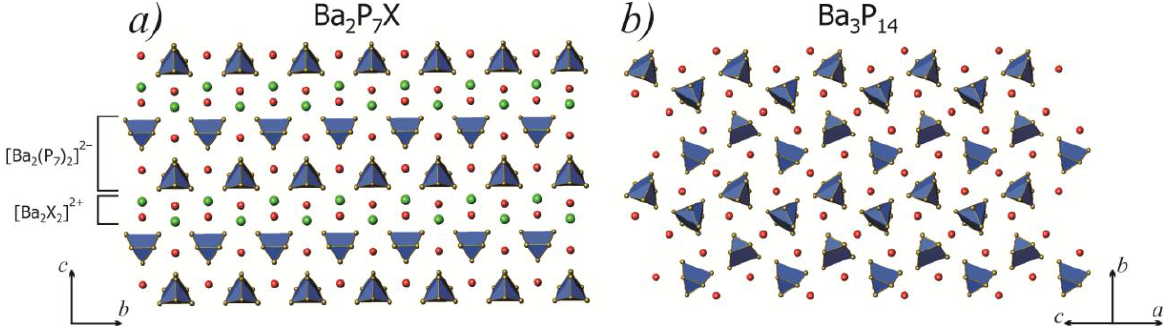
Figure 3. ( a ) The structure of the heptaphosphanortricyclane (P coordination by barium atoms in the crystal structures of Ba